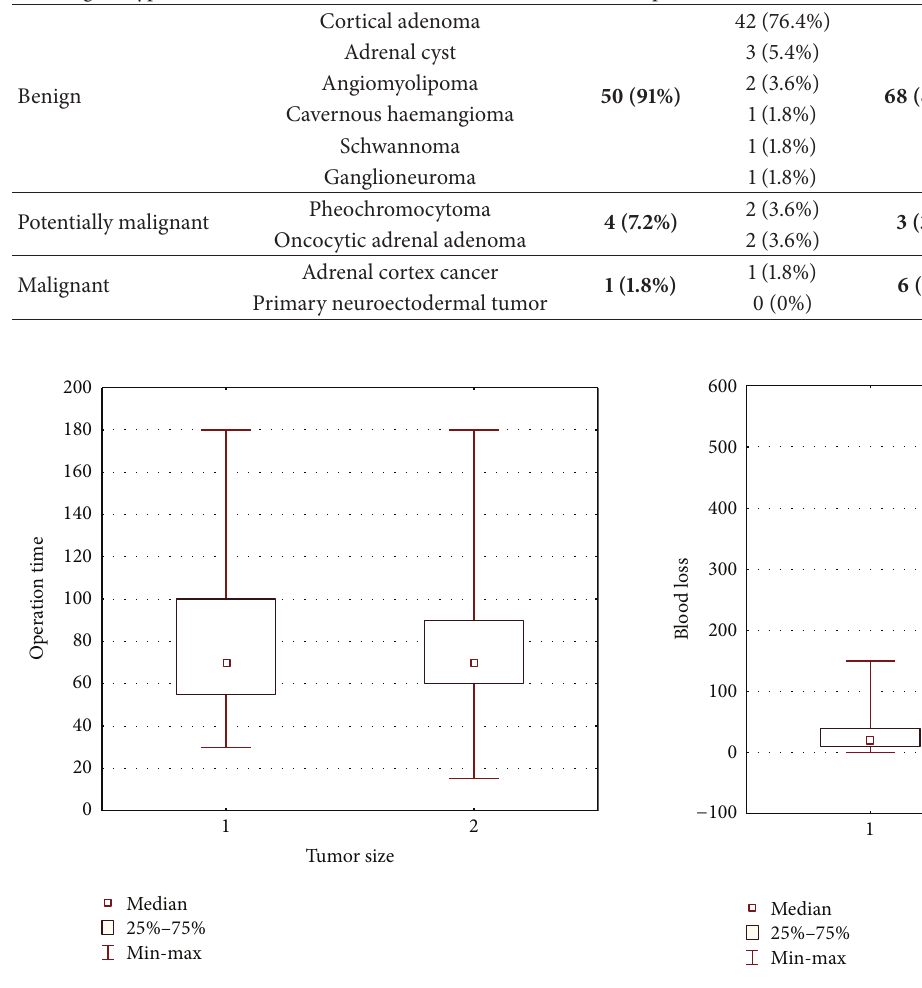
Figure 1: Mean operation time in studied groups. Figure 2: Mean estimated blood loss in studied